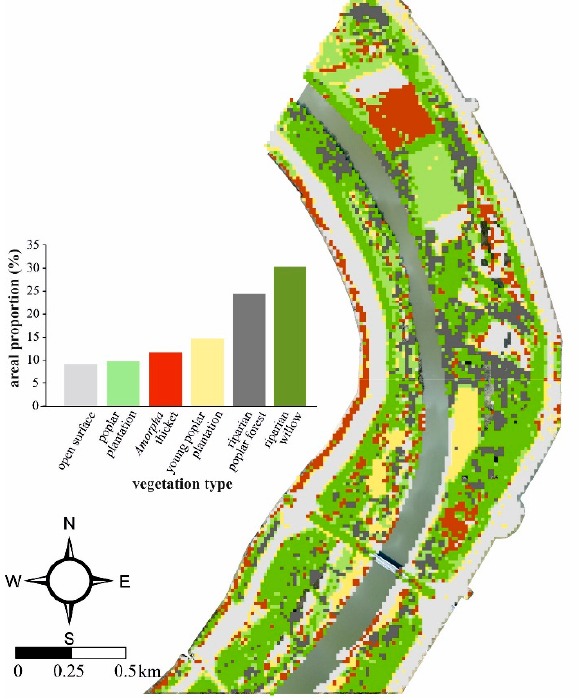
Figure 4. Spatial distribution of various vegetation types identified by machine learning applying the decision tree.